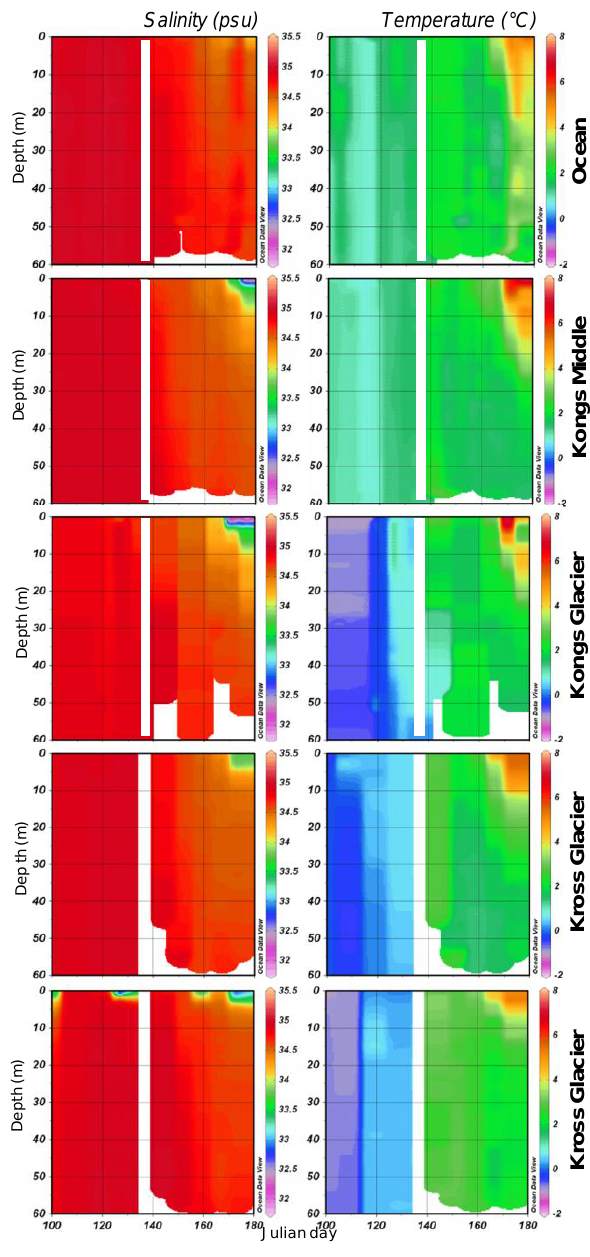
Fig. 2. Water salinity and temperature profiles of the upper 60m, and of the five sampling stations collected over time in Julian days (JD 100 is 9 April; JD 177 is 25 June). The 2008 (left panel) and 2007 (right panel) sampling periods are separated by a white sec-